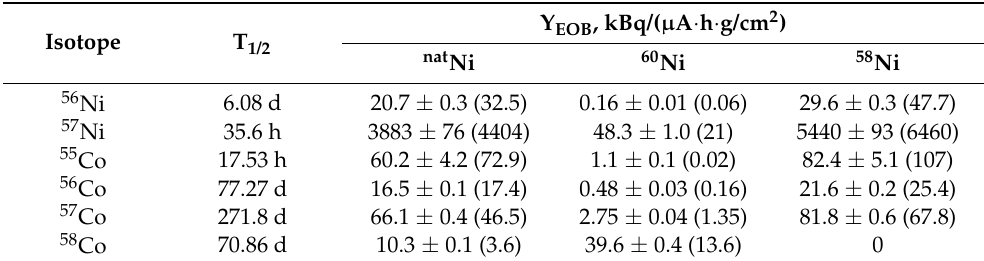
Table 1. Yields of photonuclear reactions on nat Ni, 60 Ni (obtained experimentally), and 58 Ni (calcu- lated using yields on nat Ni, 60 Ni nuclei) with maximum energy of bremsstrahlung photons being 55 MeV. Values obtained by TALYS [29] are presented in